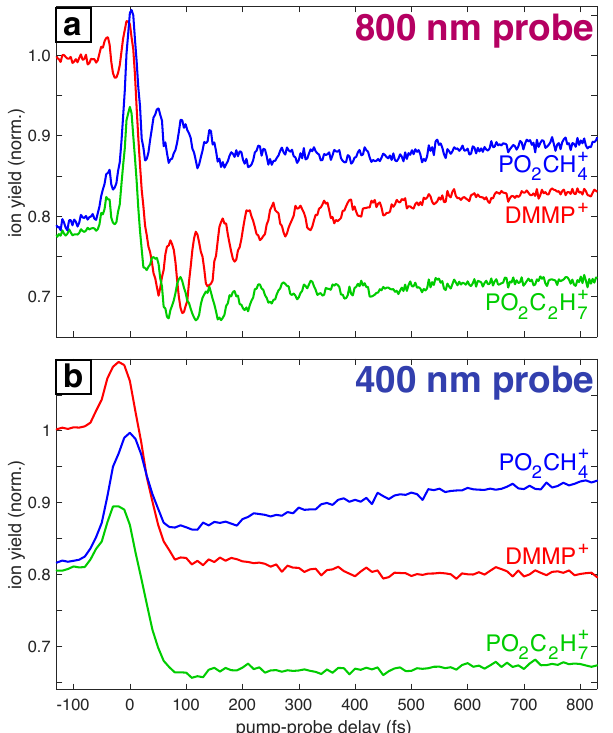
Figure 1. Transient ion signals of DMMP + (red), PO ( a ) 800 nm and ( b ) 400 nm probe